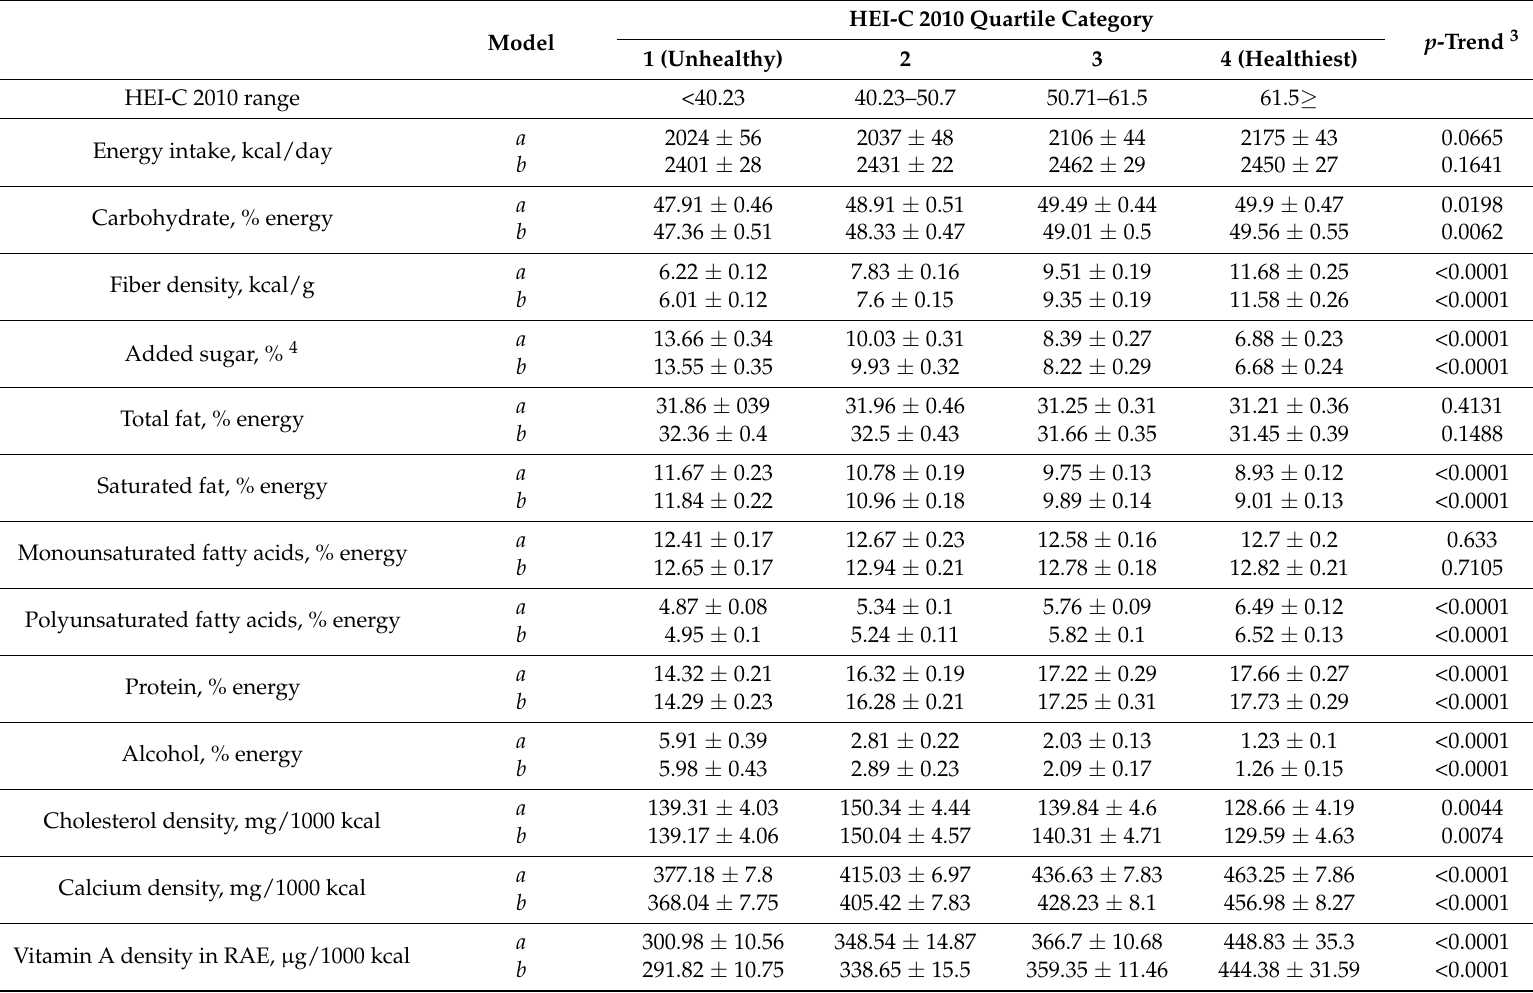
Table 2. Weighted mean daily intakes of macro- and micronutrients by quartile category of the HEI-C 2010 among Canadian adults ( n = 12,805) 1,2